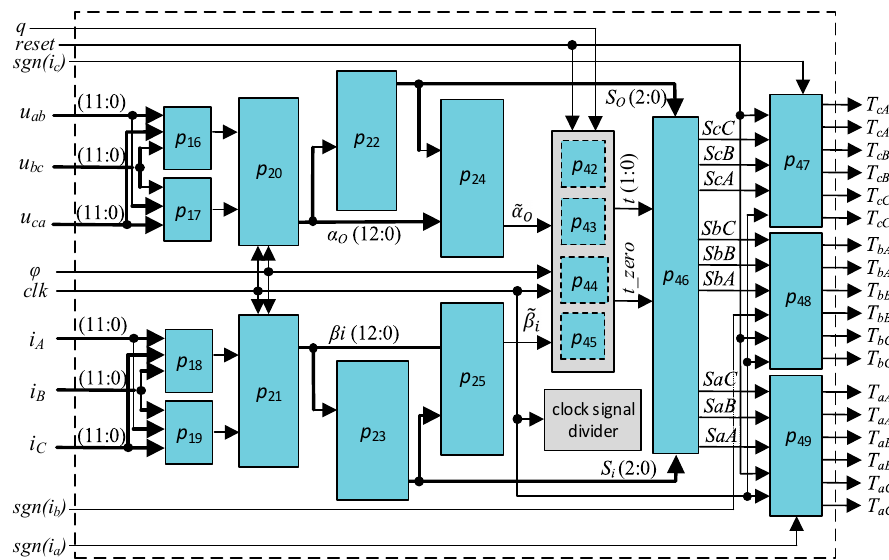
Figure 6. Diagram of the modelled system with application of hardware description language (HDL) based on the Petri net.